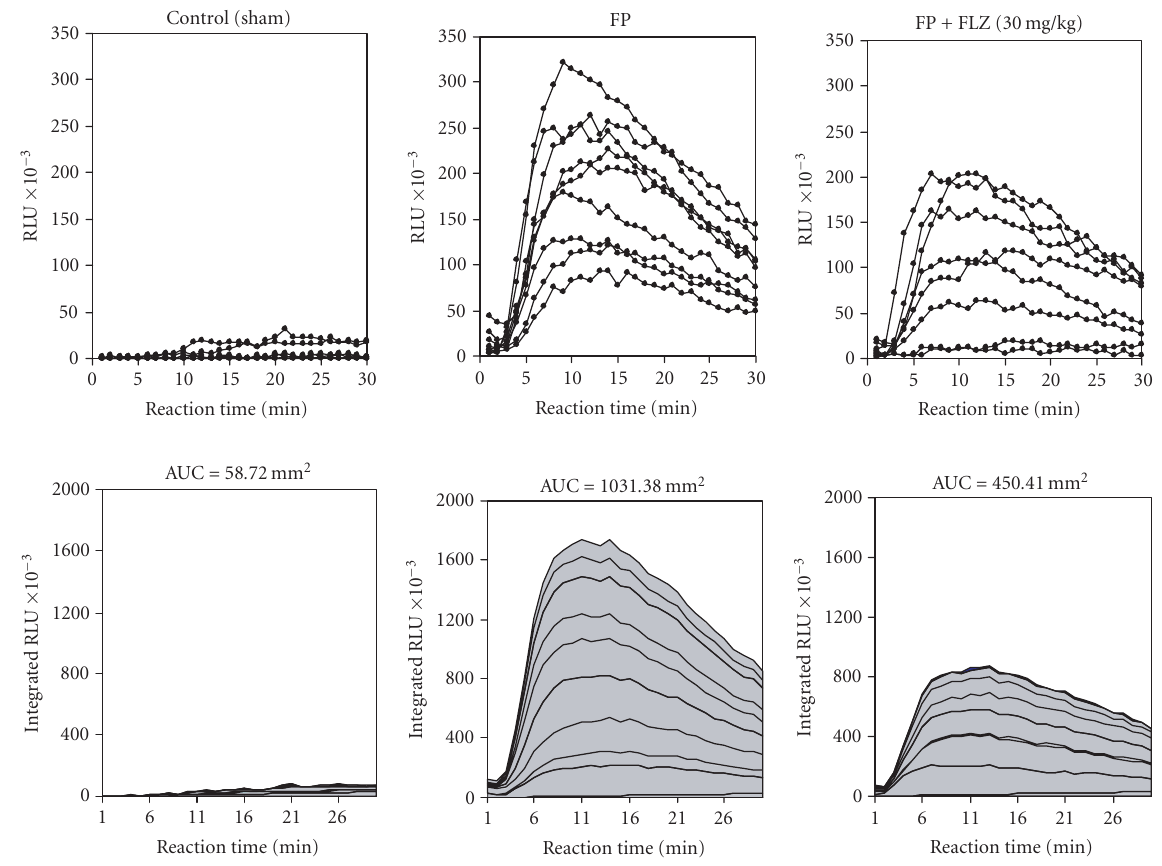
Figure 1. Real-time chemiluminescence (CL) signals from individual samples showing the e ff ect of fluconazole (FLZ) on phagocytic activity of leukocytes in the peritoneal fluid (500nL) of rats with fecal peritonitis (upper-panel line graphs). Areas under curves were used to display cumulative representation of all the samples and to measure area under curve (AUC) (lower panel). x -axes show the measurement time of each sample in the